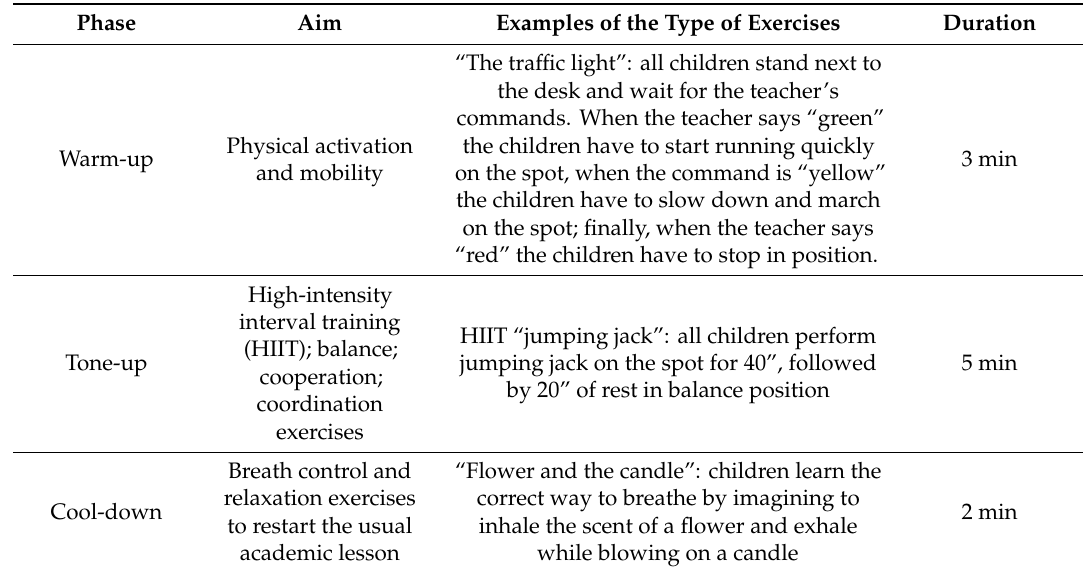
Table 1. Components of the Active Break